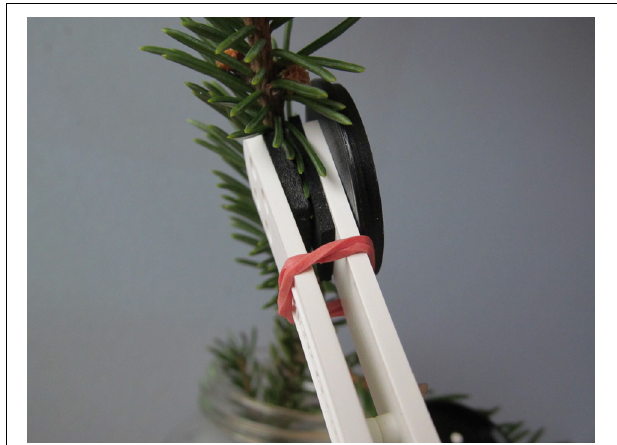
and blue lines show the long-term mean and minimum daily temperatures (red and blue, respectively) from the Finnish Meteorological Institute weather data from the years 1961 to 2012 (Venäläinen et al.,